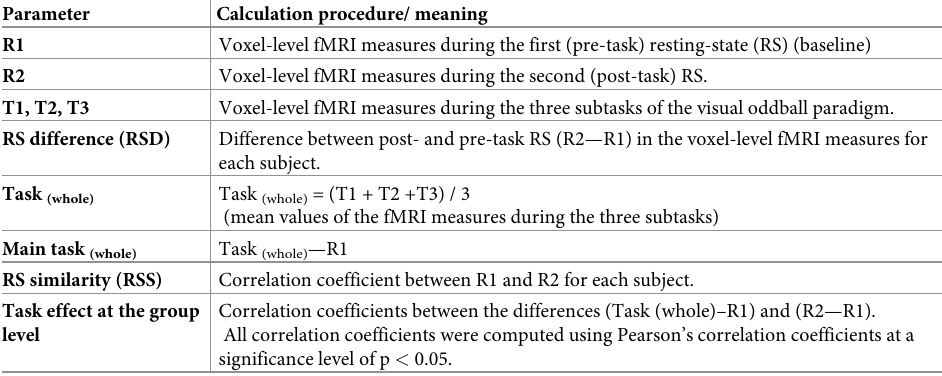
Table 1. Description of parameters used to examine the effect of the task on the fMRI measures in the post-task RS.